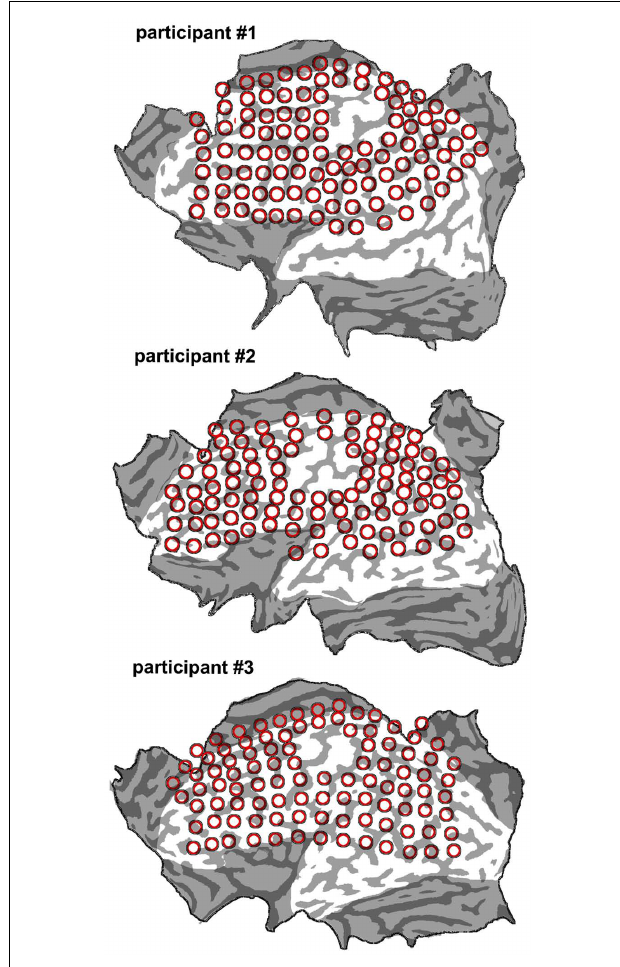
FIGURE 2 | Flat maps of the three participants’ cortical surface superimposed onto the individual grids that were used to deliver cTMS. The number of grid points was of 102 for participant 1; 99 for participant 2; and 100 for participant 3. connectedtoacustommadefigure-of-eightcoilwith25 mmwind- ings. The one delivering the cTMS pulses was a Magpro unit (Magventure, Skovlunde, Denmark) connected to an MC-B35 figure-of-eight coil with windings of 35 mm diameter. As a first step, the resting motor threshold (rMTh) was assessed with stan- dard methods (Rossini et al., 1994) separately for each coil, using the 1DI as the target muscle. Even when using different stimula- tor types, adjusting intensities to the individual stimulator motor threshold allows to compare the effects of the two stimulators (Rothkegel et al.,